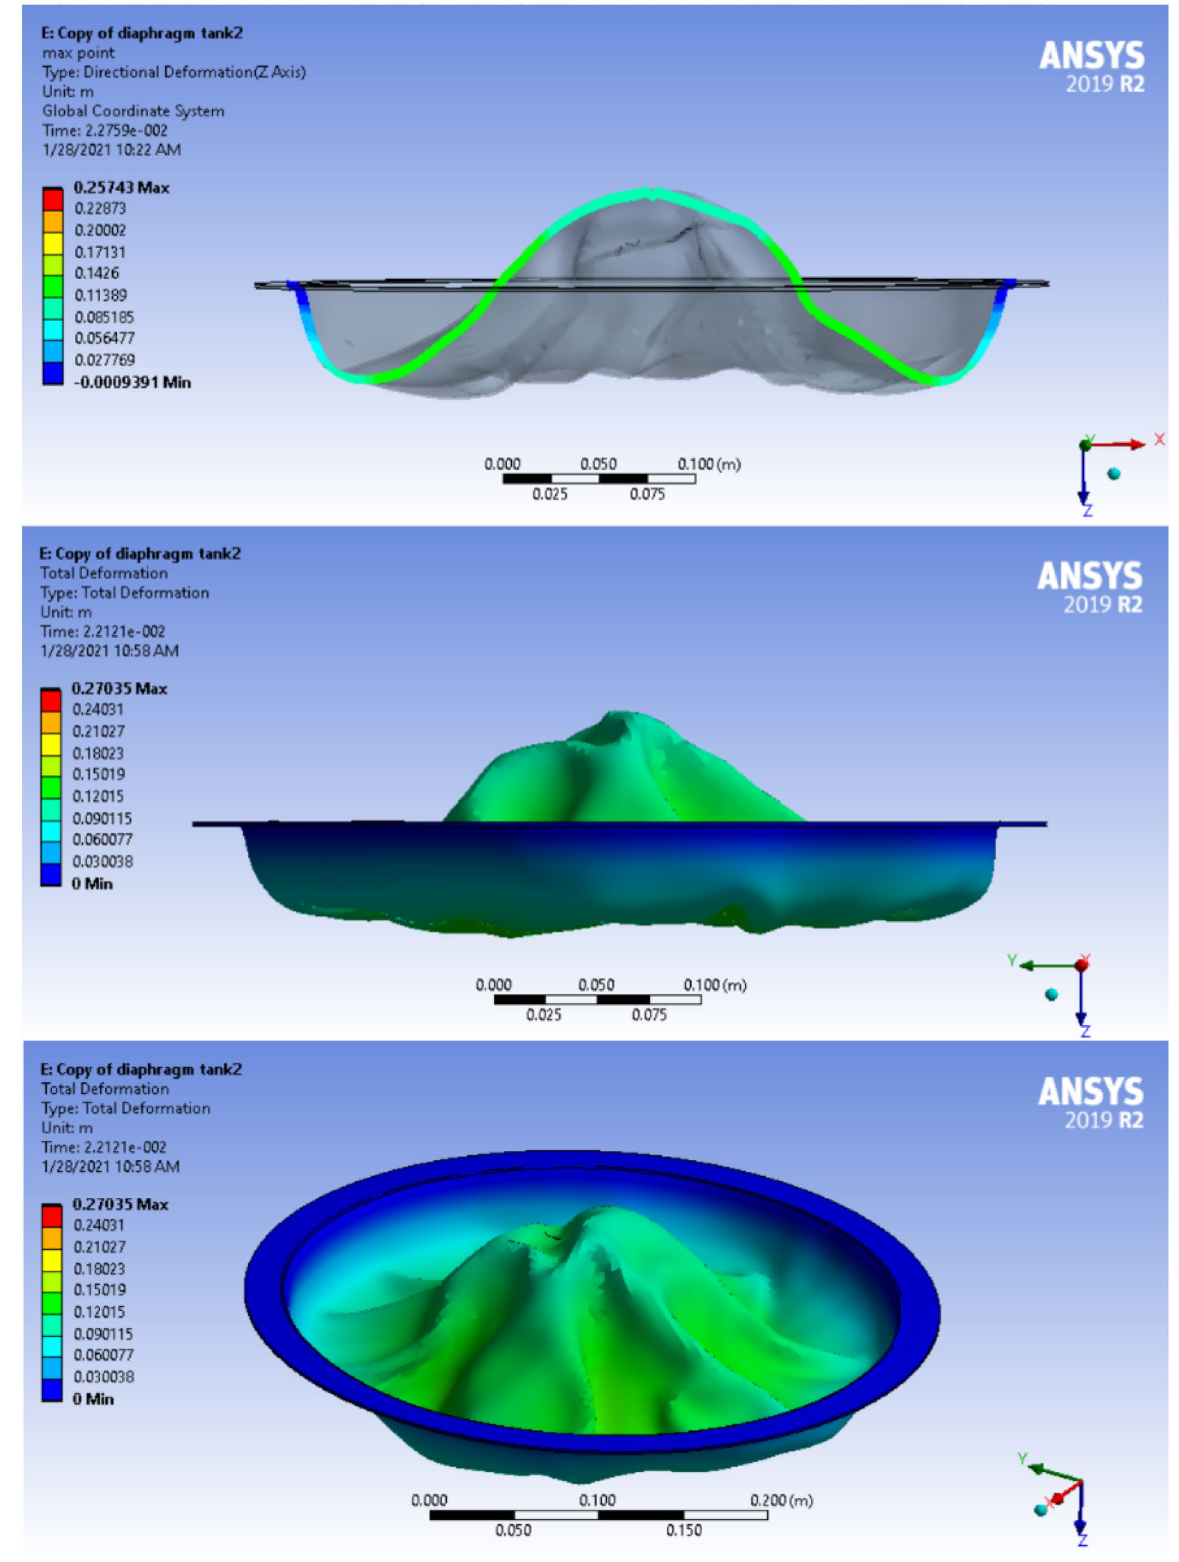
Fig. 21 The results of numerical analysis in volume of 50% taking into account the tensile